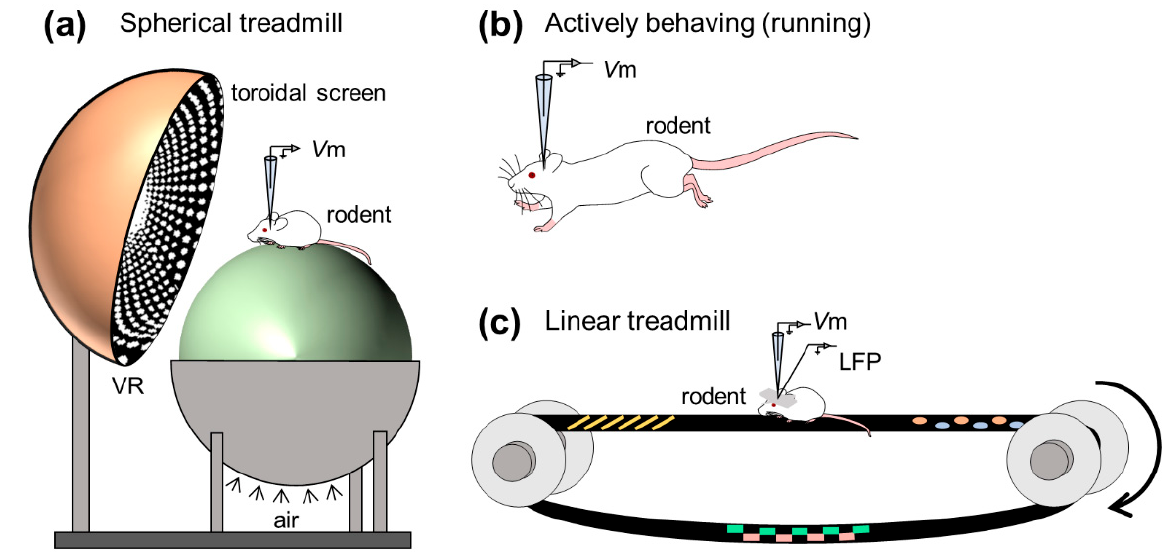
Figure 4. Examples of studies based on in vivo whole-cell recordings from hippocampal neurons of behaving animals. ( a ) Whole-cell recordings are made from hippocampal neurons of an animal running on the spherical treadmill with a virtual reality system. ( b ) Whole-cell recordings are made from the neurons of actively running animals. ( c ) Membrane potentials and local field potentials are simultaneously recorded from an animal running on the linear treadmill. Abbreviations : V m, membrane potential; LFP, local field potential; VR, virtual reality.